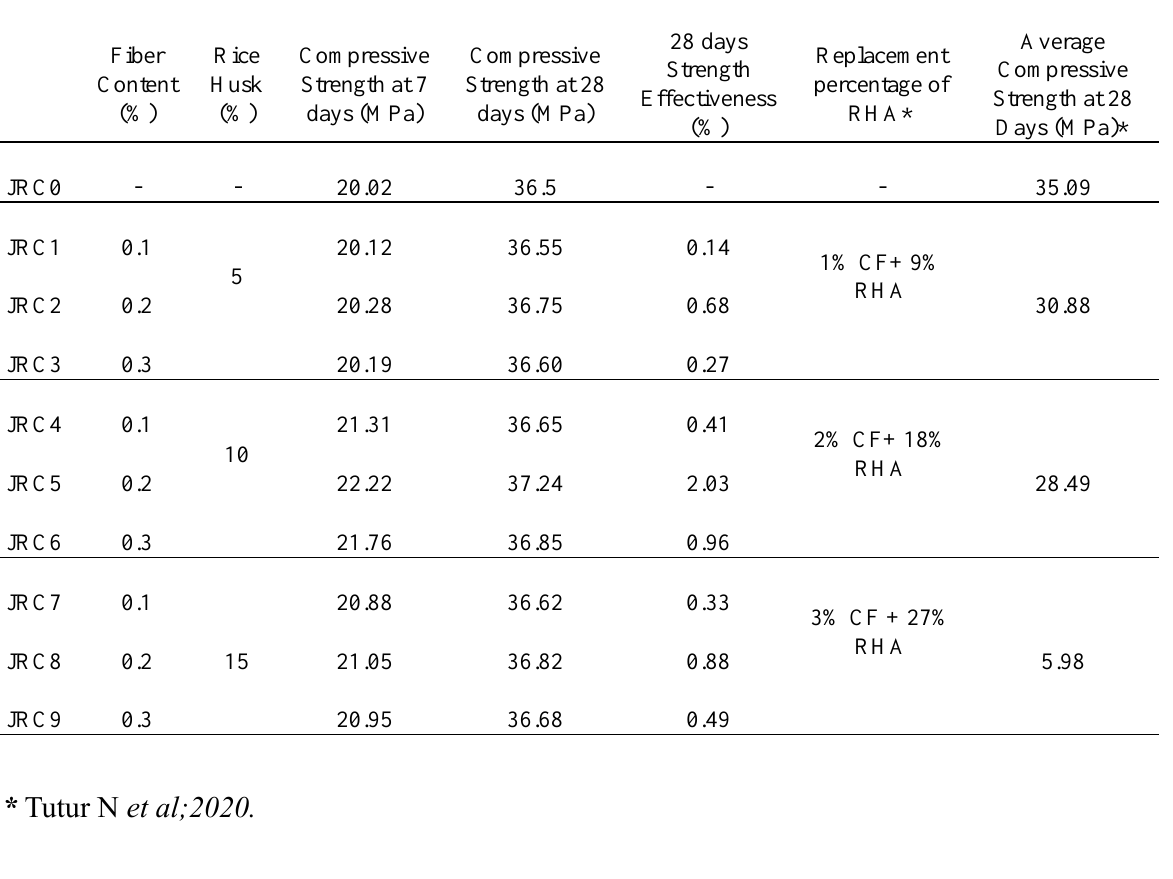
Compressive strength and strength